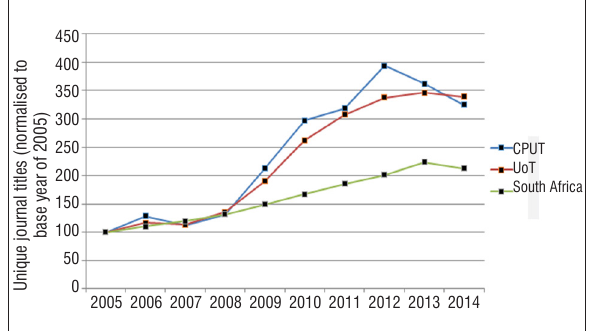
Figure 4: Growth in unique journal titles over a 10-year